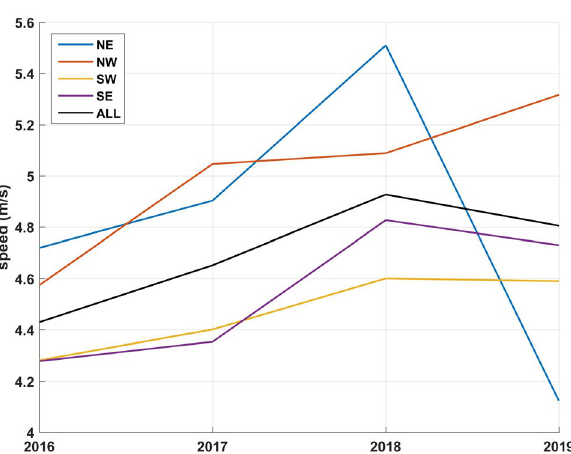
Figure 6. Average wind speed of the study area per main quadrant (direction from), as reported at Dog Island (Fortune Bay). NE = Northeast, NW = Northwest, SW = Southwest, SE = Southeast and ALL =